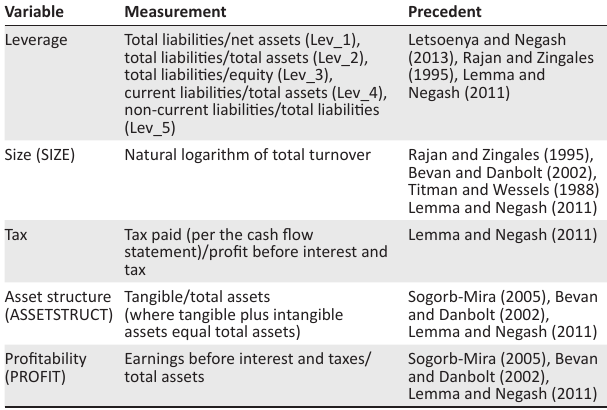
TABLE 3: Measurement of variables.